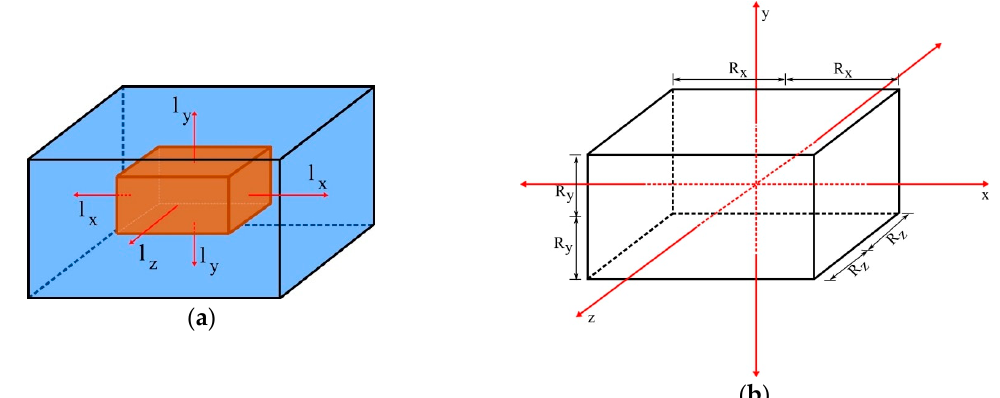
Figure 1. Parallelepipedic solid ( a ) immersed in a fluid medium and ( b ) with its geometric parameters.